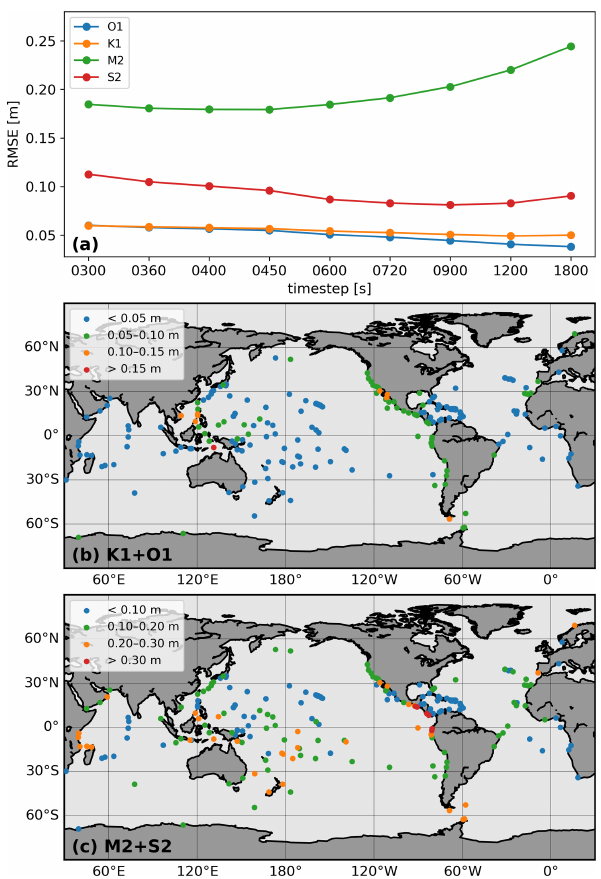
Figure A2. (a) RMSE of the four main tidal components (O1, K1, M2 and S2 tides) for all 229 tide gauges. (b) In the sensitivity run with time step set to 720s, RMSE of the main diurnal tidal compo- nents (O1 and K1 tides) at each tide-gauging station. Scatter points are classified into four levels by the magnitudes of RMSE. (c) The same as panel (b) but for the main semidiurnal tidal components (M2 and S2